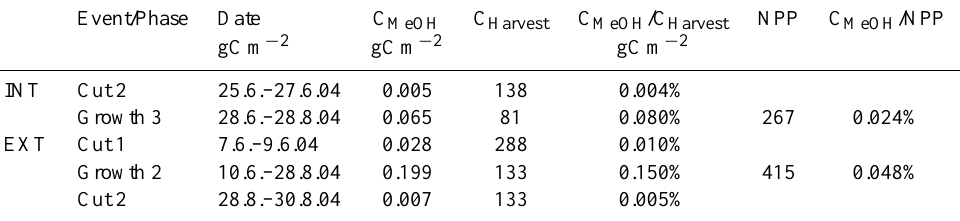
Table 4. Accumulated cut- and growth-related methanol emission (C MeOH ) , net primary productivity (NPP), and harvest yield (C Harvest ) of the intensive and the extensive grassland. Growth related emissions are referred to the harvest yield of the following